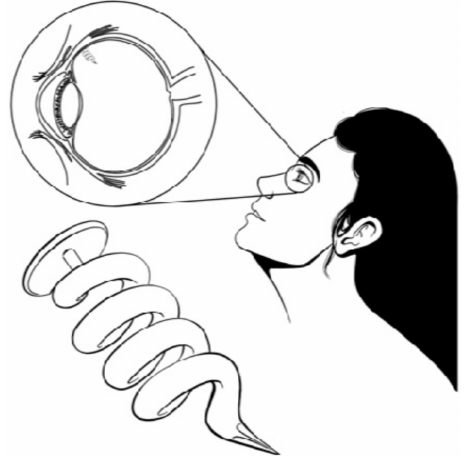
Figure 6. I-vation (helical-shaped